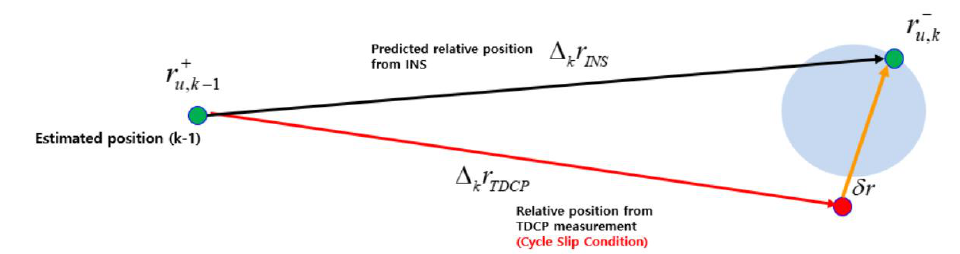
Figure 6. Relationship between INS and TDCP-based relative positions (cycle slip condition).